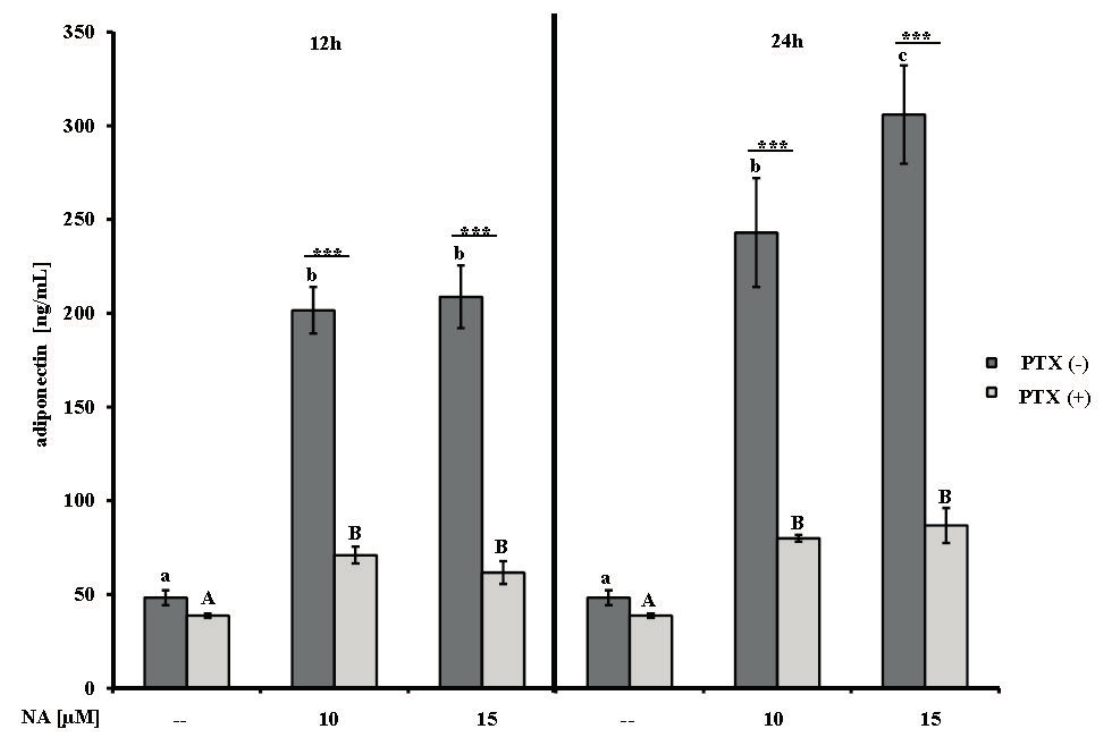
drastically limited this increase by 50%, but the values remained 5-fold higher than those of the respective controls ( p ≤ 0.001). A representative Western blot result is shown in Figure 2b. Figure 1. The effects of nicotinic acid (NA) on adiponectin concentrations (means ± SEM) in cell culture supernatants of differentiated bovine adipocytes ( n = 5). After 4 h of serum starvation, the adipocytes were pre-incubated with pertussis toxin (PTX (+)) or without (PTX ( − )) (100 ng/mL) for 16 h and then treated for 12 or 24 h with 10 or 15 µM NA or PBS (vehicle control). The different lower case letters designate significant differences ( p ≤ 0.005) between the NA treatments and the controls for the PTX ( − ) cells; the different upper case letters designate significant differences ( p ≤ 0.001) between the NA treatments and the controls for the PTX (+) cells. Significant differences ( *** p ≤ 0.001) due to PTX (+) or PTX ( − ) pre-incubation for each NA treatment group are indicated with